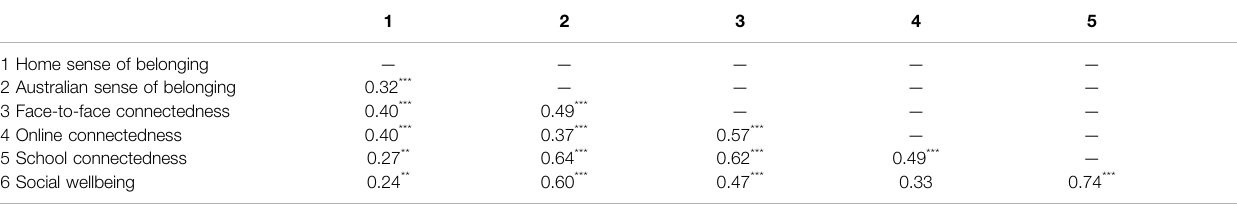
TABLE 2 | Correlations between the regression variables ( N (cid:1) 225).